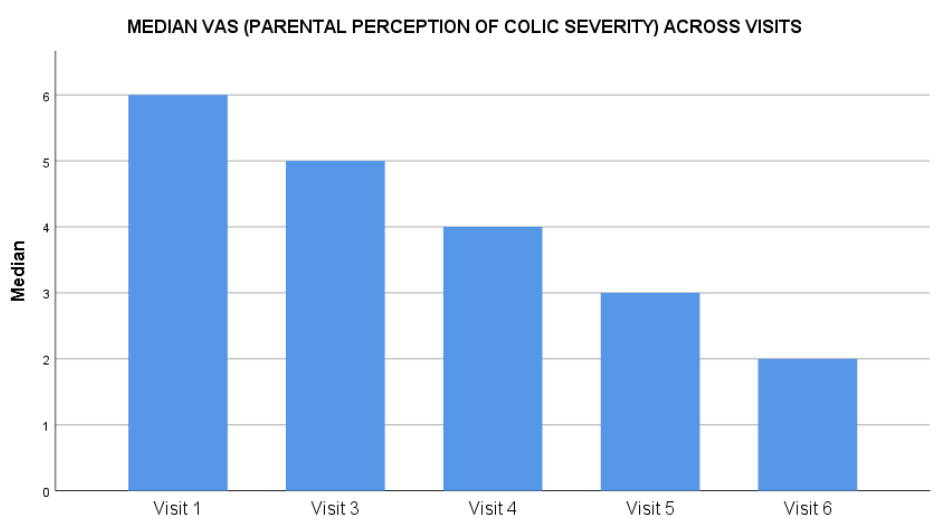
Figure 4. Impact of Lactobacillus reuteri DSM 17938 administration on parental perception of colic severity during the treatment.